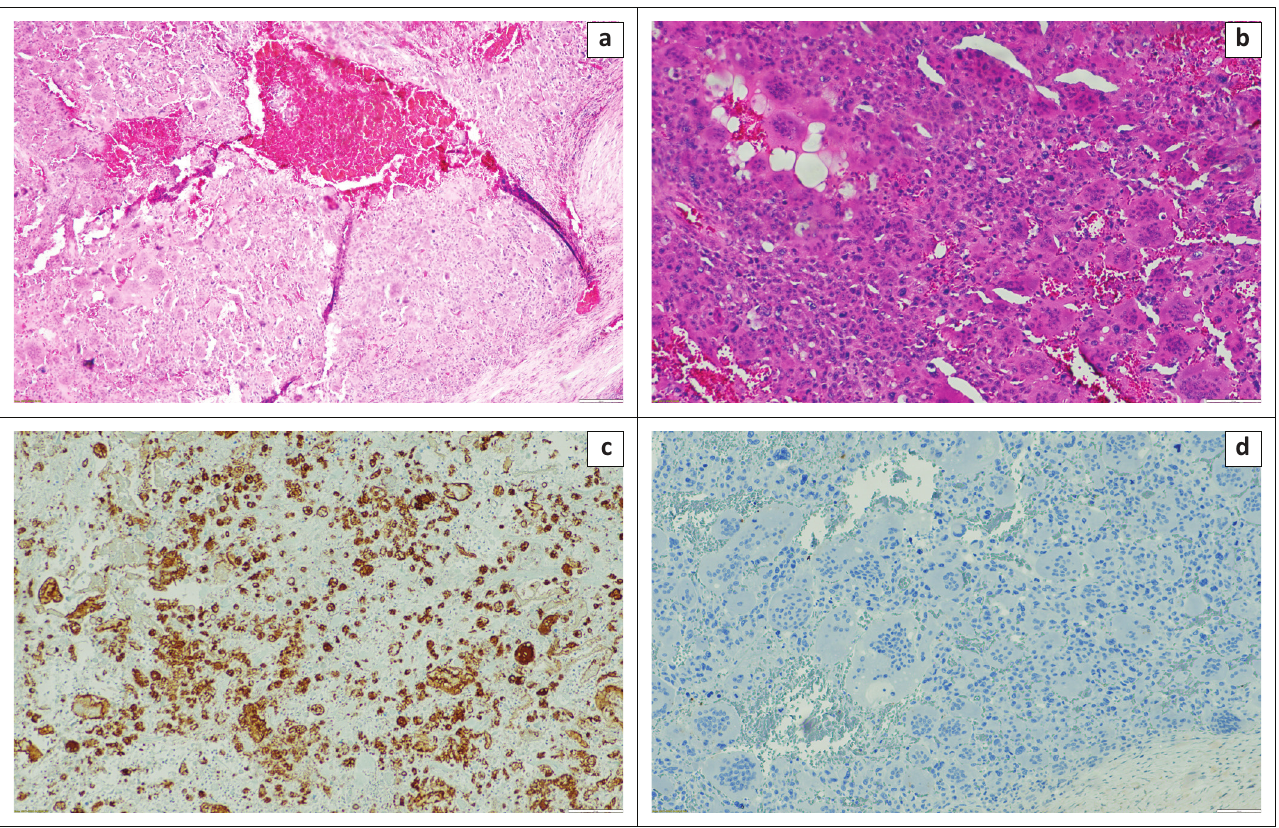
FIGU RE 3: Histology of the surgical specimen. The tumour was composed mainly of oval and spindle mononuclear histiocyte-like cells and multinucleated giant cells; hematoxylin and eosin stain, × 4 (a) × 20 (b). Immunohistochemistry of the tumour. Oval and spindle mononuclear histiocyte – like cells and multinucleated giant cells stain positively for CD68 (c) and negatively for AE1/3 and MNF – 116 (d).